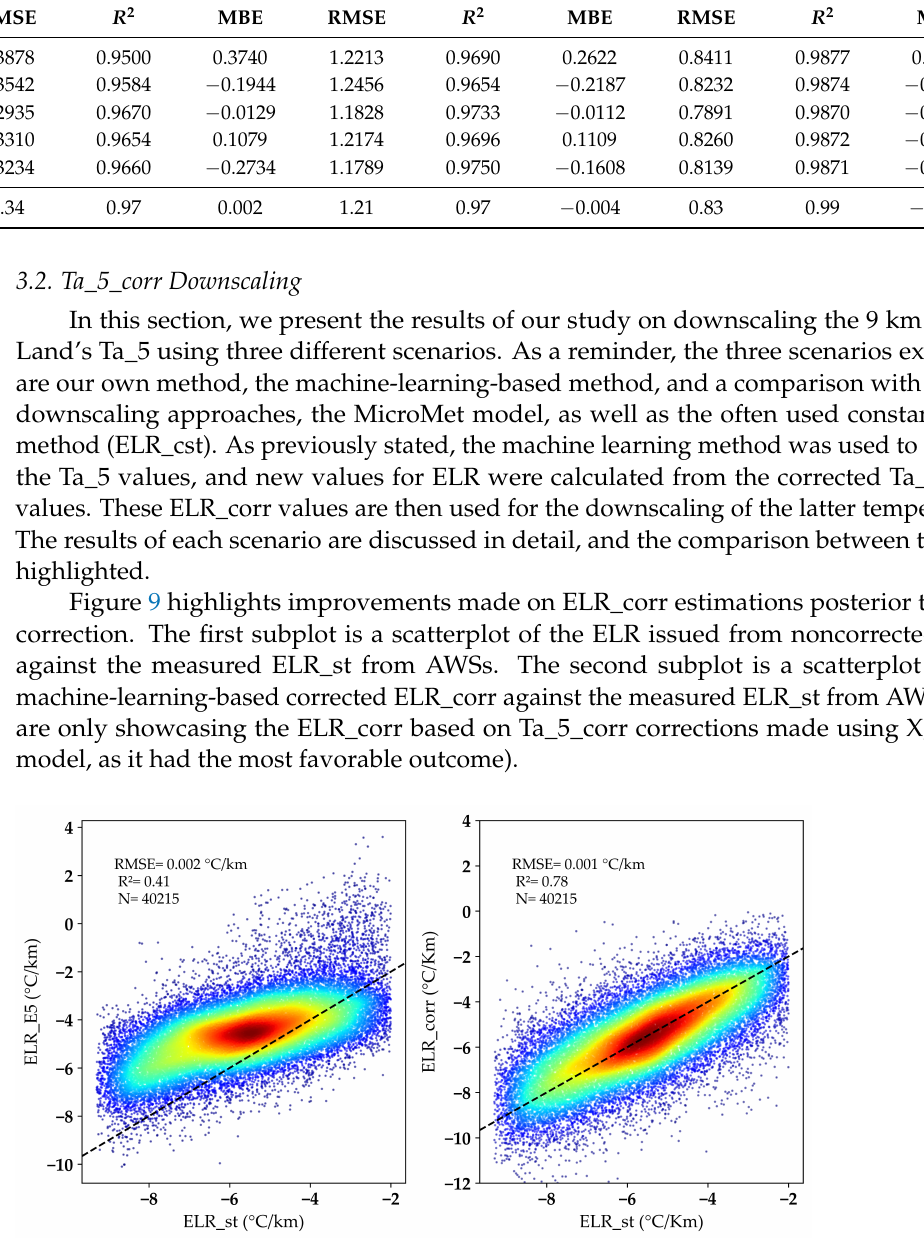
Figure 9. Comparison of noncorrected and corrected Ta_5 resulting